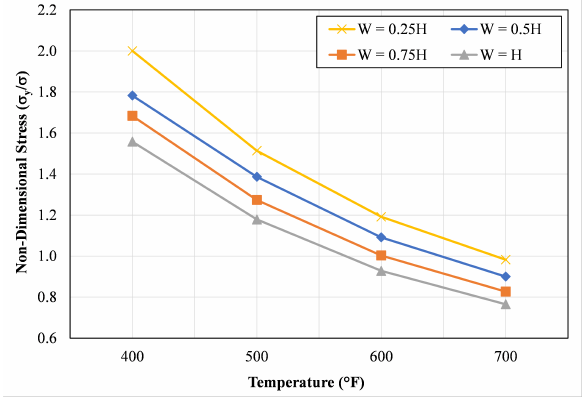
Figure 8: Relationship between σ A / σ of the 16-inch diameter expan- sion loops pipe with increasing